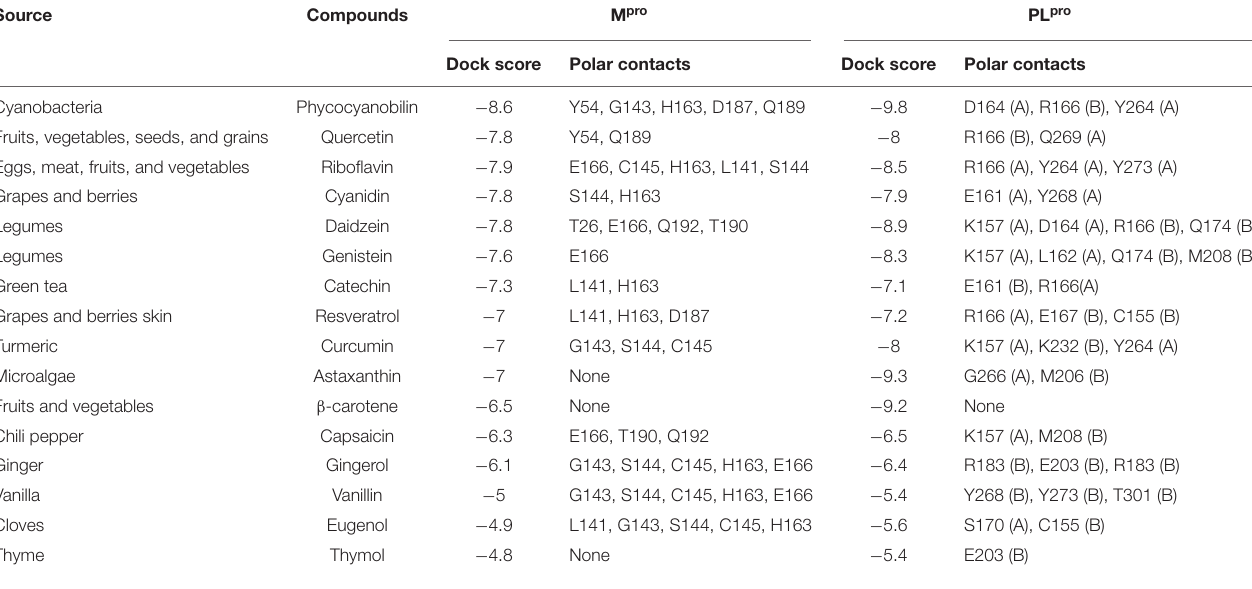
TABLE 2 | Molecular docking results of food bioactive compounds with COVID-19 main protease (M pro ), papain-like protease (PL pro